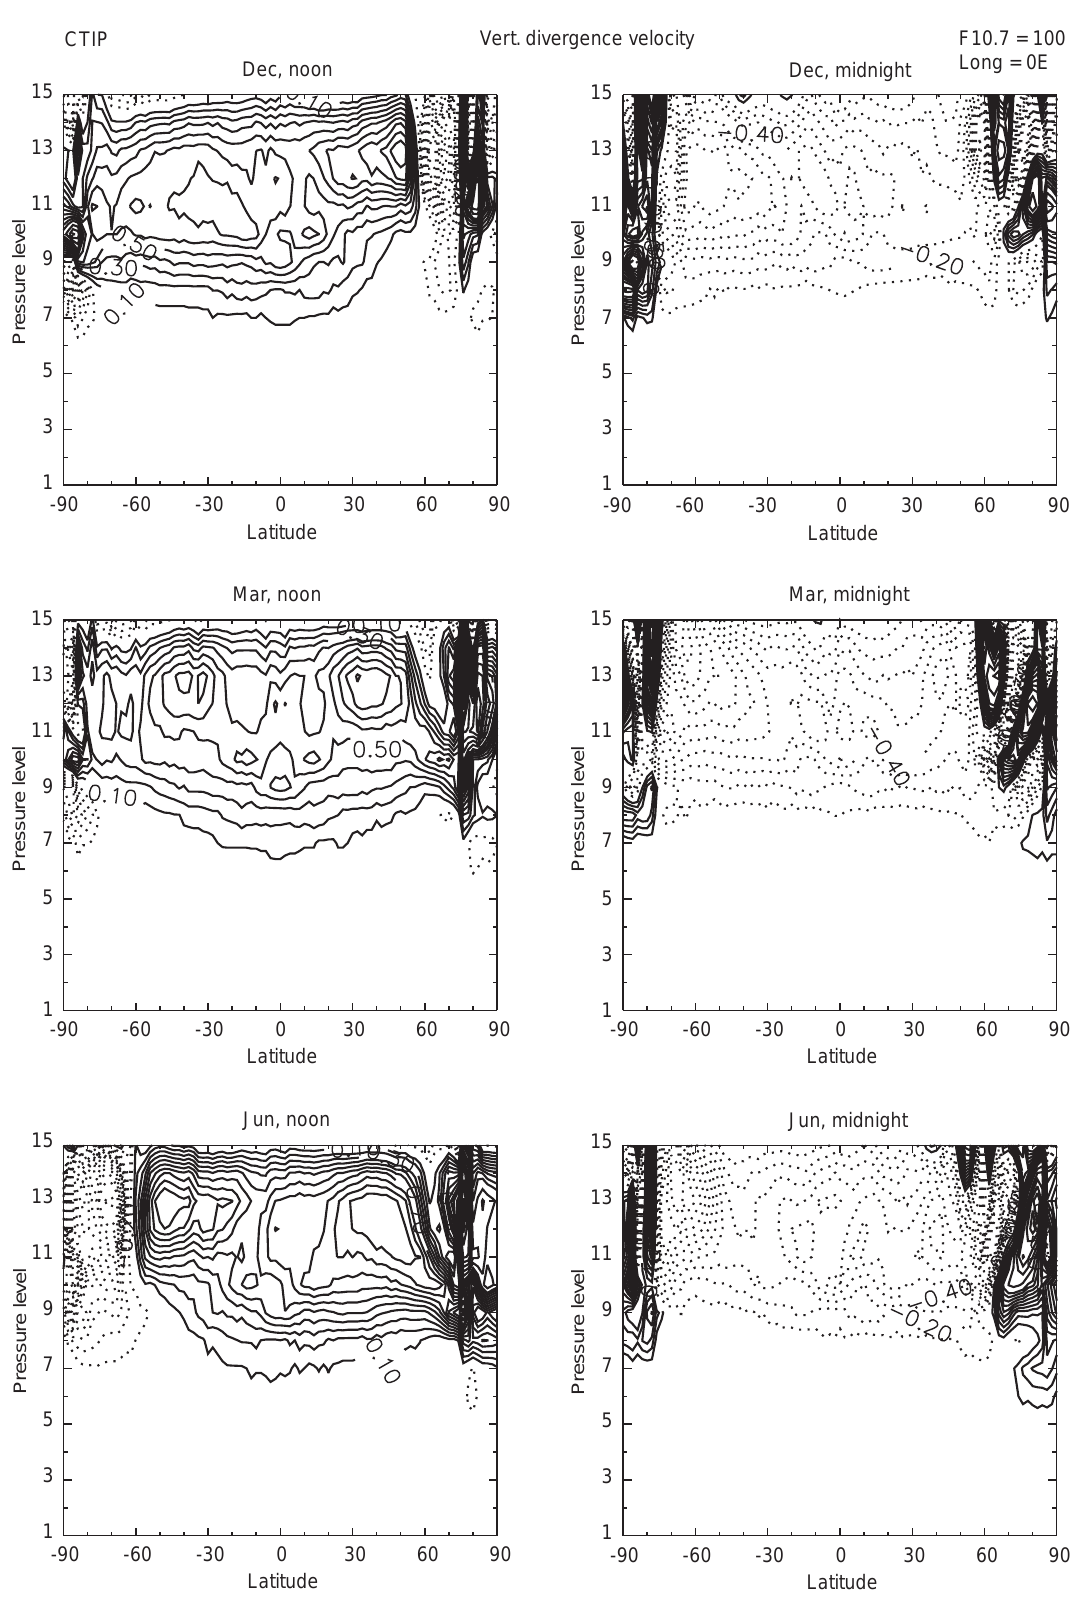
Fig. 5. Cross sections of divergence velocity W D versus geographic latitude and pressure-level Z at local noon and midnight, longitude 0 (cid:14) , for December, March and June. The contour interval is 0.1 m s (cid:255) 1 . At middle and low latitudes (i.e. excluding auroral